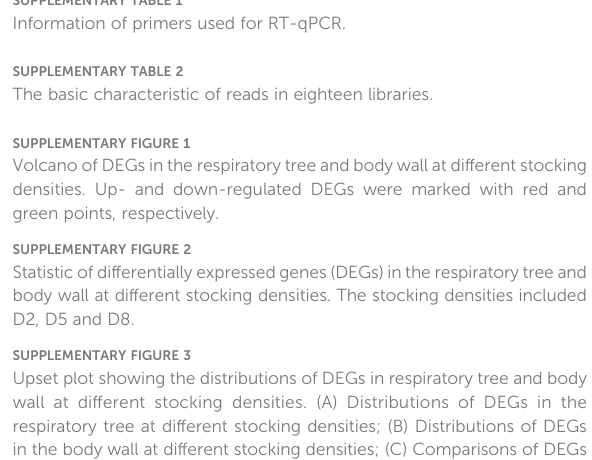
SUPPLEMENTARY TABLE 1 Information of primers used for RT-qPCR. SUPPLEMENTARY TABLE 2 The basic characteristic of reads in eighteen libraries. SUPPLEMENTARY FIGURE 1 Volcano of DEGs in the respiratory tree and body wall at different stocking densities. Up- and down-regulated DEGs were marked with red and green points, respectively. SUPPLEMENTARY FIGURE 2 Statistic ofdifferentially expressed genes(DEGs)inthe respiratorytreeand body wall at different stocking densities. The stocking densities included D2, D5 and D8. SUPPLEMENTARY FIGURE 3 Upset plot showing the distributions of DEGs in respiratory tree and body wall at different stocking densities. (A) Distributions of DEGs in the respiratory tree at different stocking densities; (B) Distributions of DEGs in the body wall at different stocking densities; (C) Comparisons of DEGs at the same stocking density between the respiratory tree and body